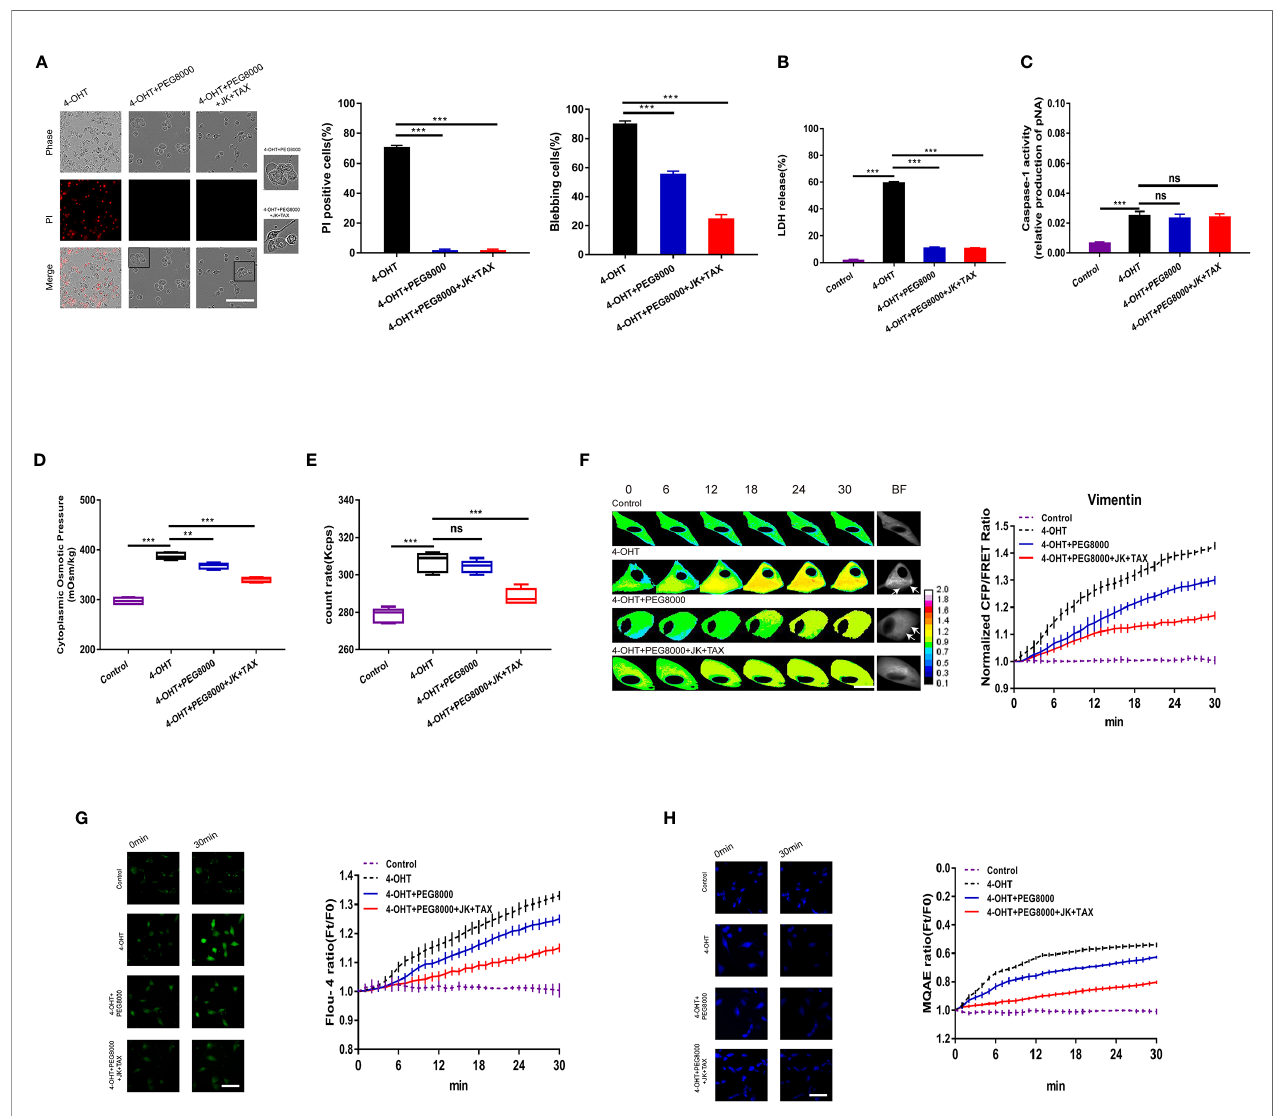
FIGURE 5 | Blockade of non-selective pores using PEG8000 prevented membrane permeabilization but did not affect cell swelling. (A) Representative time-lapse images of U87 cells under 4-OHT treatment, and co-treatments of 4-OHT with PEG8000, and the additional MF/MT stabilizers (JK and TAX). Cell membrane integrity was monitored by PI uptake (red fl uorescence). The bar charts represent PI positive and blebbing cells. (B) LDH release and (C) caspase-1 activity of cells. (D) The cytoplasmic OP values. (E) The count rate of PNs in U87 cells. (F) Representative images and mean values of normalized CFP/FRET ratios of Vimentin tension under the different treatments. Arrows indicate the membrane blebbing regions. (G) Calcium imaging micrographs and traces of relative Fluo-4 fl uorescence intensity (Ft/F0) of cells. (H) Chloridion imaging micrographs and traces of relative MQAE fl uorescence intensity (Ft/F0) of cells. Mean of ≥ 3 experiments ± SEM. Values marked with asterisks are signi fi cantly different, as determined using a t -test. ns, not signi fi